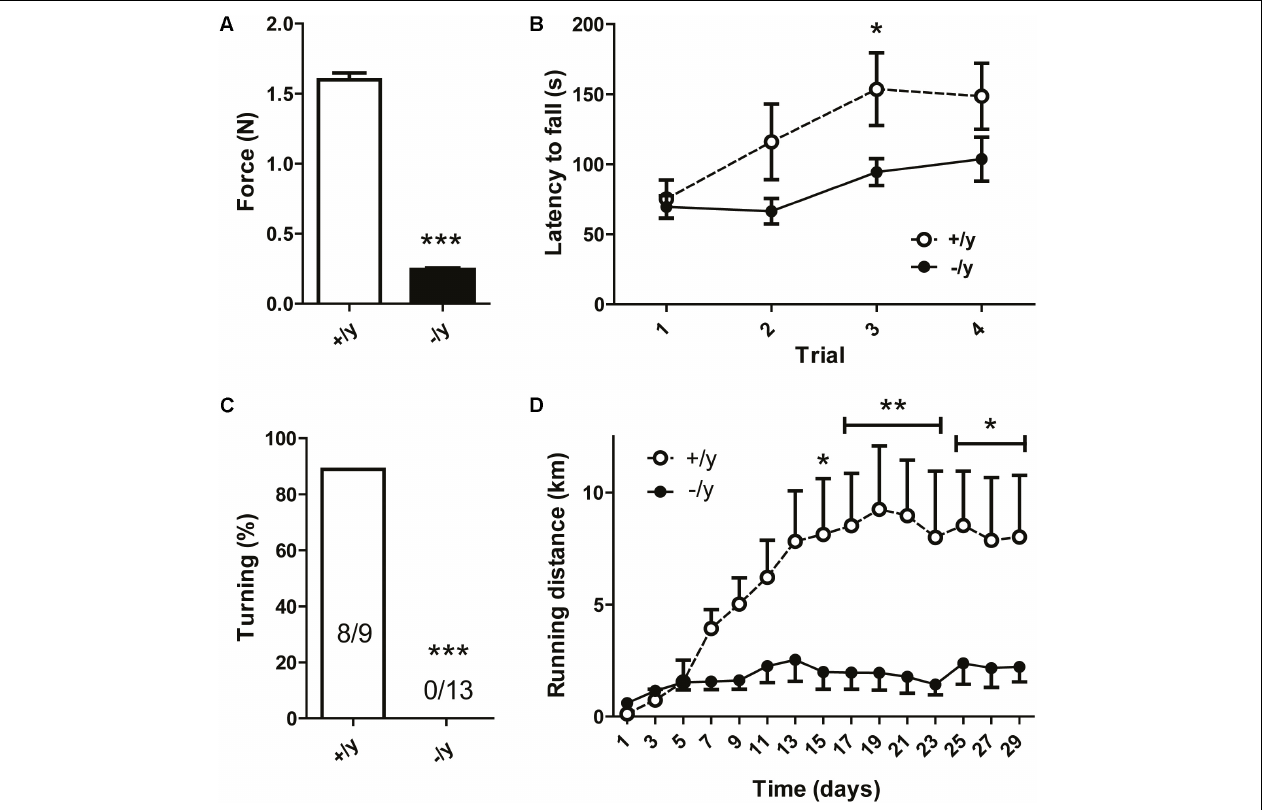
FIGURE 4 | Motor and behavioral phenotype of CT1-deficient mice. Grip strength (A) , rotarod performance (B) , successful turning in pole test (C) , and voluntary running distance (D) of CT1 + / y and CT1 − / y male littermates ( n = 9–15) ( ∗ P < 0.05; ∗∗ P < 0.01; ∗∗∗ P <